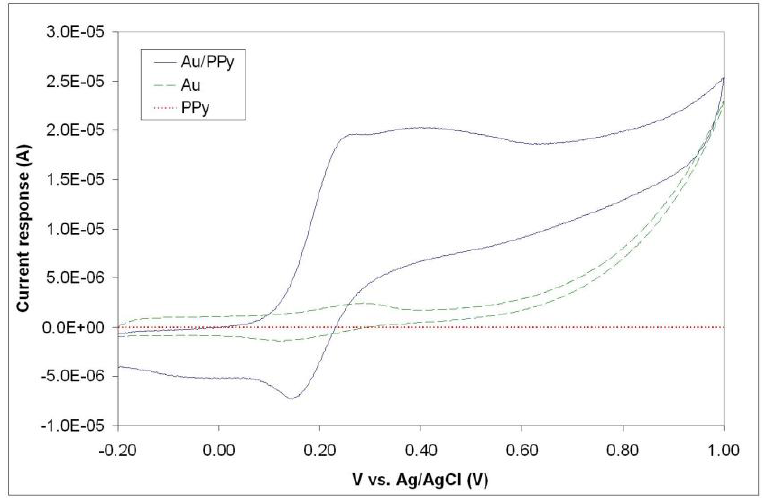
Figure 6. Cyclic voltammograms of single 3D microelectrodes in Au, PPy, and Au/PPy combination, obtained in a 10 mM Ferrocyanide aqueous solution in PBS (pH 7.4), using a Ag/AgCl (3M KCl) reference electrode and a Pt wire counter electrode. Voltage is cycled from −0.2 to 1.0 V with a potential sweep rate of 200